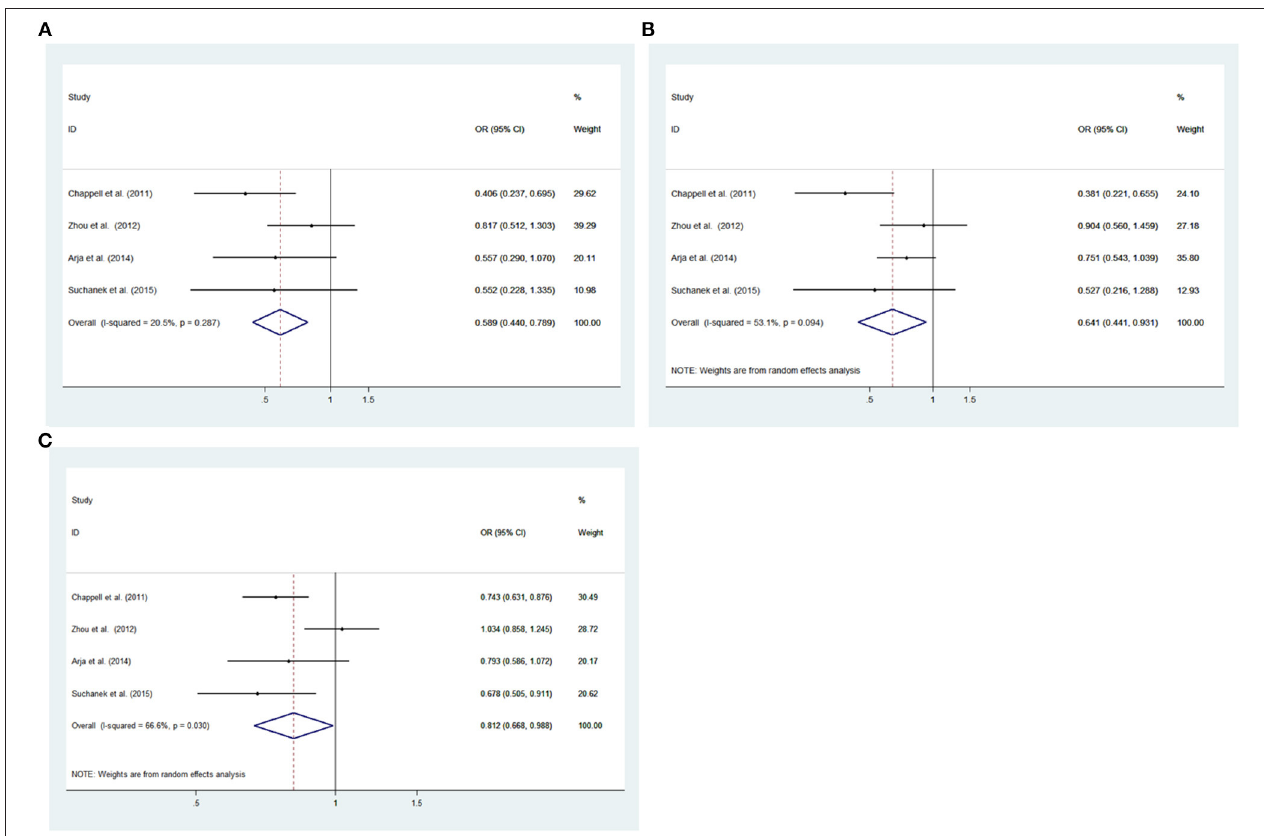
FIGURE 3 | Meta-analysis for the association between the IREB2 rs2656069 polymorphism and COPD susceptibility. (A) Recessive model, GG vs. AA + AG (fixed effects model). (B) Additive model, GG vs. AA (random effects model). (C) Allele model, G vs. A (random effects model). OR, odds ratio; CI, confidence interval; I-squared, measure to quantify the degree of heterogeneity in meta-analyses.